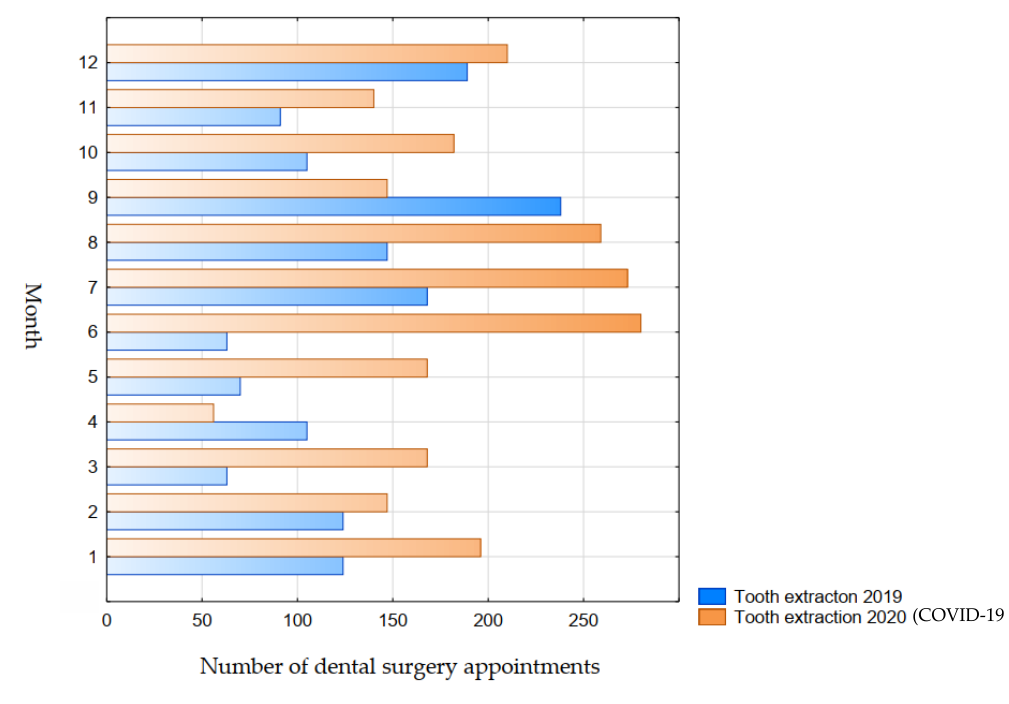
Figure 4. Change in the number of dental surgery appointments during the pandemic period from the prepandemic period.